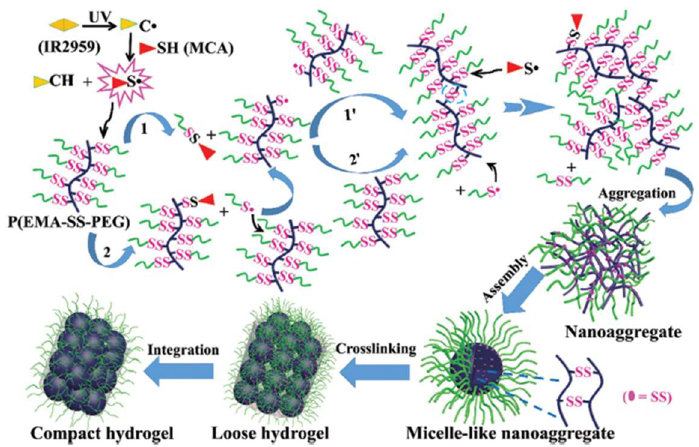
Figure 5. The mechanism of UV-triggered thiol-disulfide exchange for the formation of hydrogels. Image reproduced with permission from [40]. Copyright 2016 RSC.